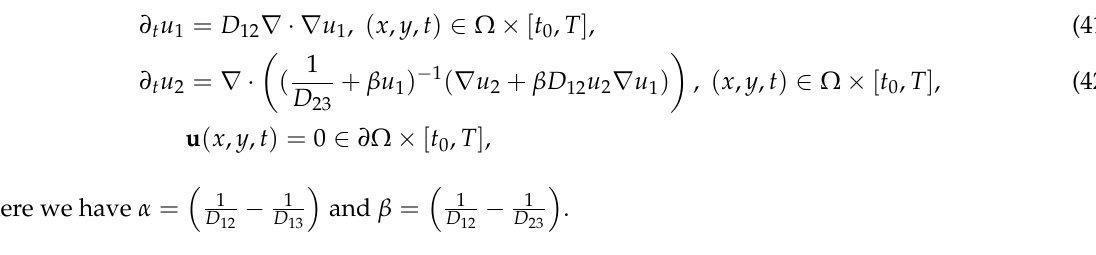
Table 11. Results of the shifted Strang–Marchuk’s splitting, (SSMS), and the shifted linear iterative splitting, SLIS, for the CDR equation for different tolerances. Shifted Tolerance Time Tentative Functional Max Error Mean